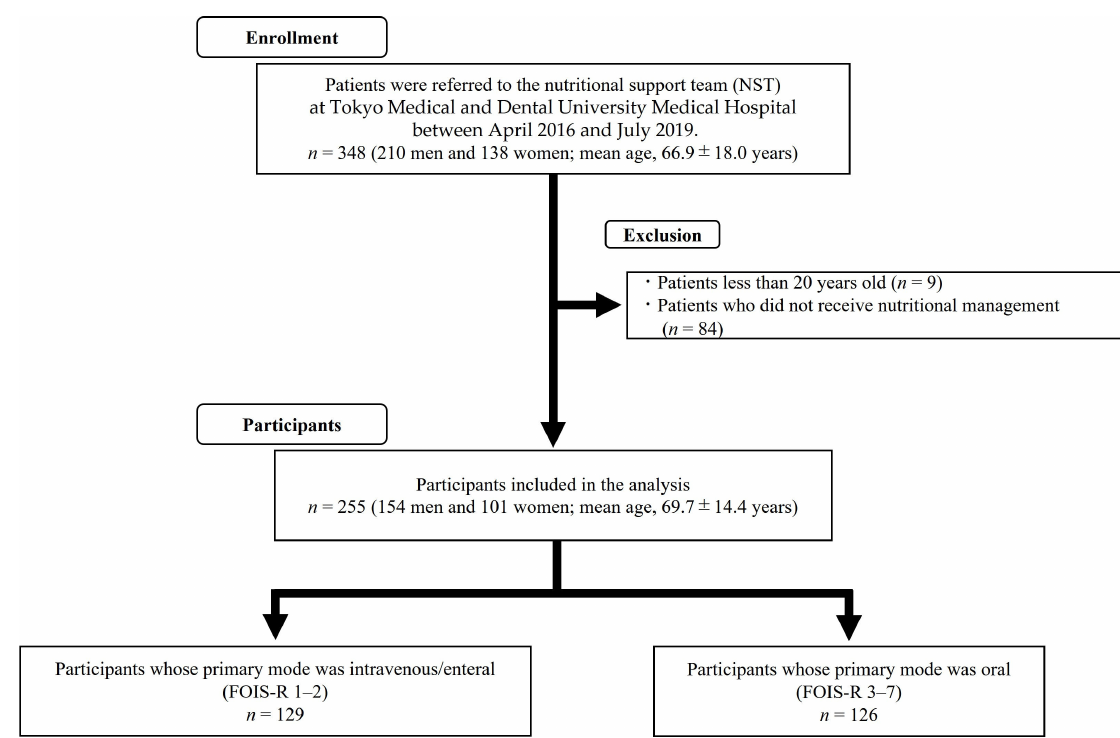
Figure 1. Enrollment process used in this cross-sectional study. Abbreviation: FOIS-R: Functional Oral Intake